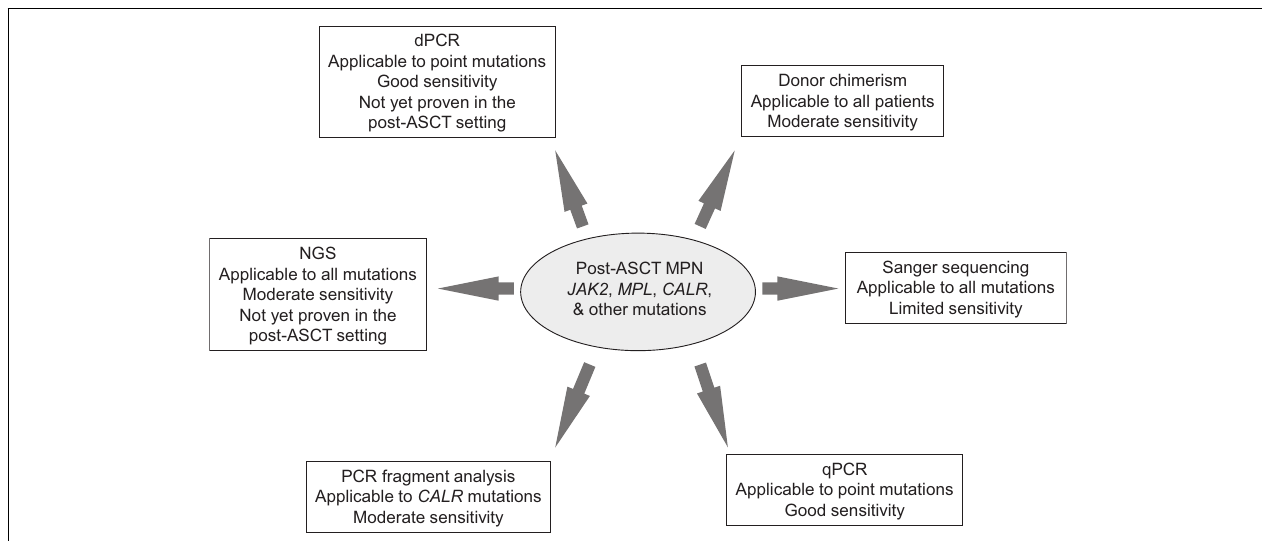
FIGURE 1 | Summary of methodologies for monitoring MPN-specific mutations post-allogeneic stem cell transplantation . ASCT, allogeneic stem cell transplantation; MPN, myeloproliferative neoplasm; qPCR, quantitative polymerase chain reaction; NGS, next generation sequencing; and dPCR, digital polymerase chain